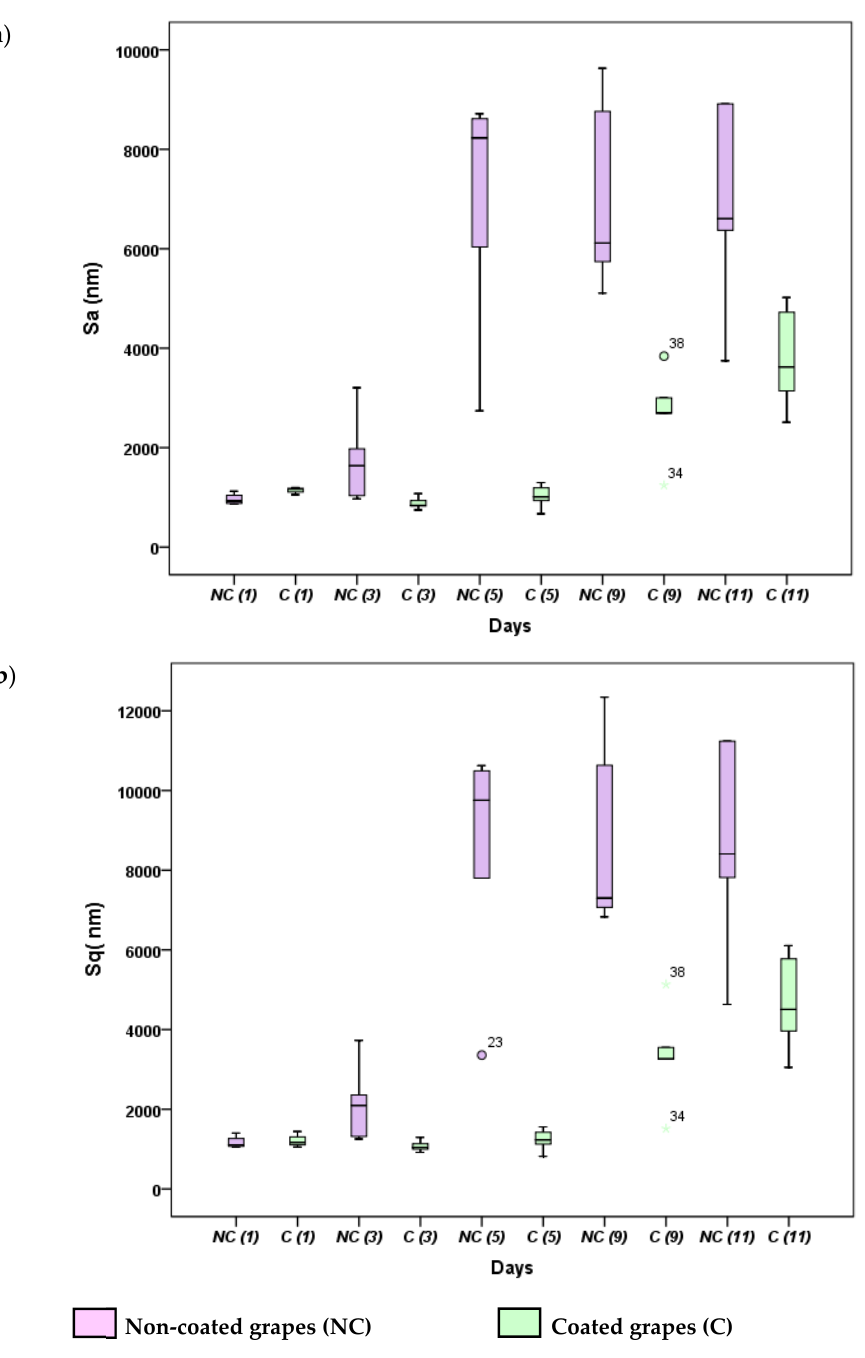
Figure 3. Statistical analysis of Sa ( a ) and Sq ( b ), considering fine structure and shape, for non-coated and coated grapes after 11 days of storage represented by boxplots.